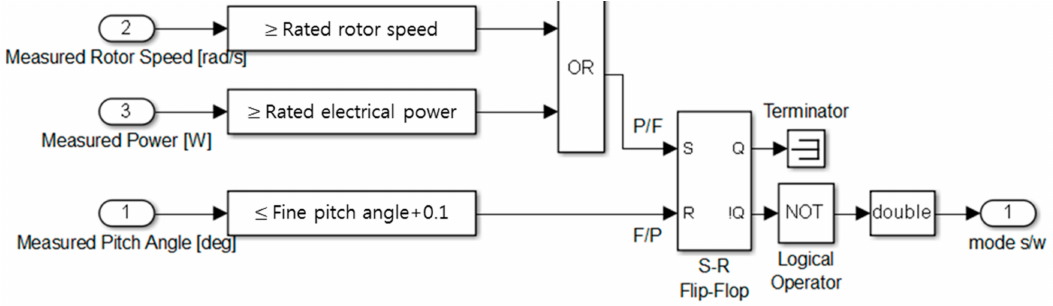
Figure 5. Block diagram of mode